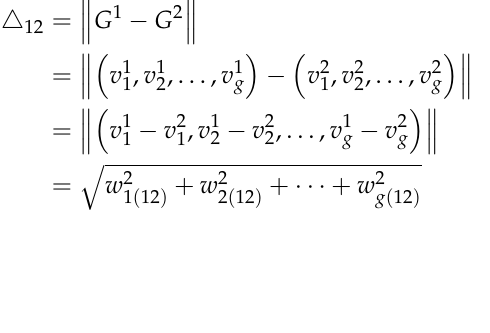
Figure 1B: Interprenetrating subsamples G1 and G2 are drawn from population 1 and G3 and G4 are drawn from population 2. Combined Figure 1. ( A ) Fractile graphs give the individual and combined fractile group means from samples fractile graphs G12 represents the fractile means of population 1, while drawn from the same population. The error area between the graphs gives an indication of the G34 for population 2. In addition, the eror areas between G1 and G2, variation, whereas the solid line G12 gives the average estimate with 20 fractile groups. ( B ) Inter- and that between G3 and G4 gives indication of the variation of the prenetrating subsamples G1 and G2 are drawn from population 1, and G3 and G4 are drawn from combined graph from each population. The area of separation is the population 2. Combined fractile graph G12 represents the fractile means of population 1, whereas space between the two combined graphs, which indicates how di⁄erent G34 is for population 2. In addition, the error area between G1 and G2, and that between G3 and G4, the two populations are after controlling for the rank of some coviarate. gives indication of the variation of the combined graph from each population. The area of separation is the space between the two combined graphs, which indicates how different the two populations are after controlling for the rank of some